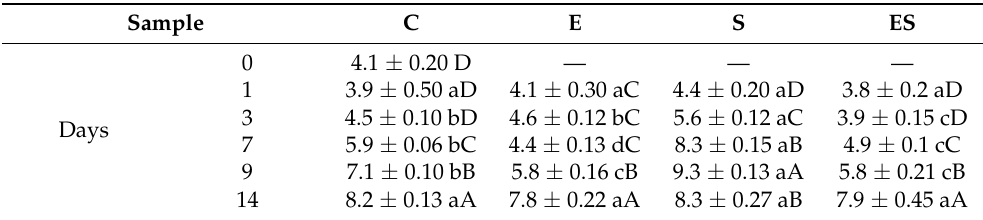
with inoculum (S); with 8% ethanol-water extract (E); with 8% of extract and inoculum (ES). Sample C E S